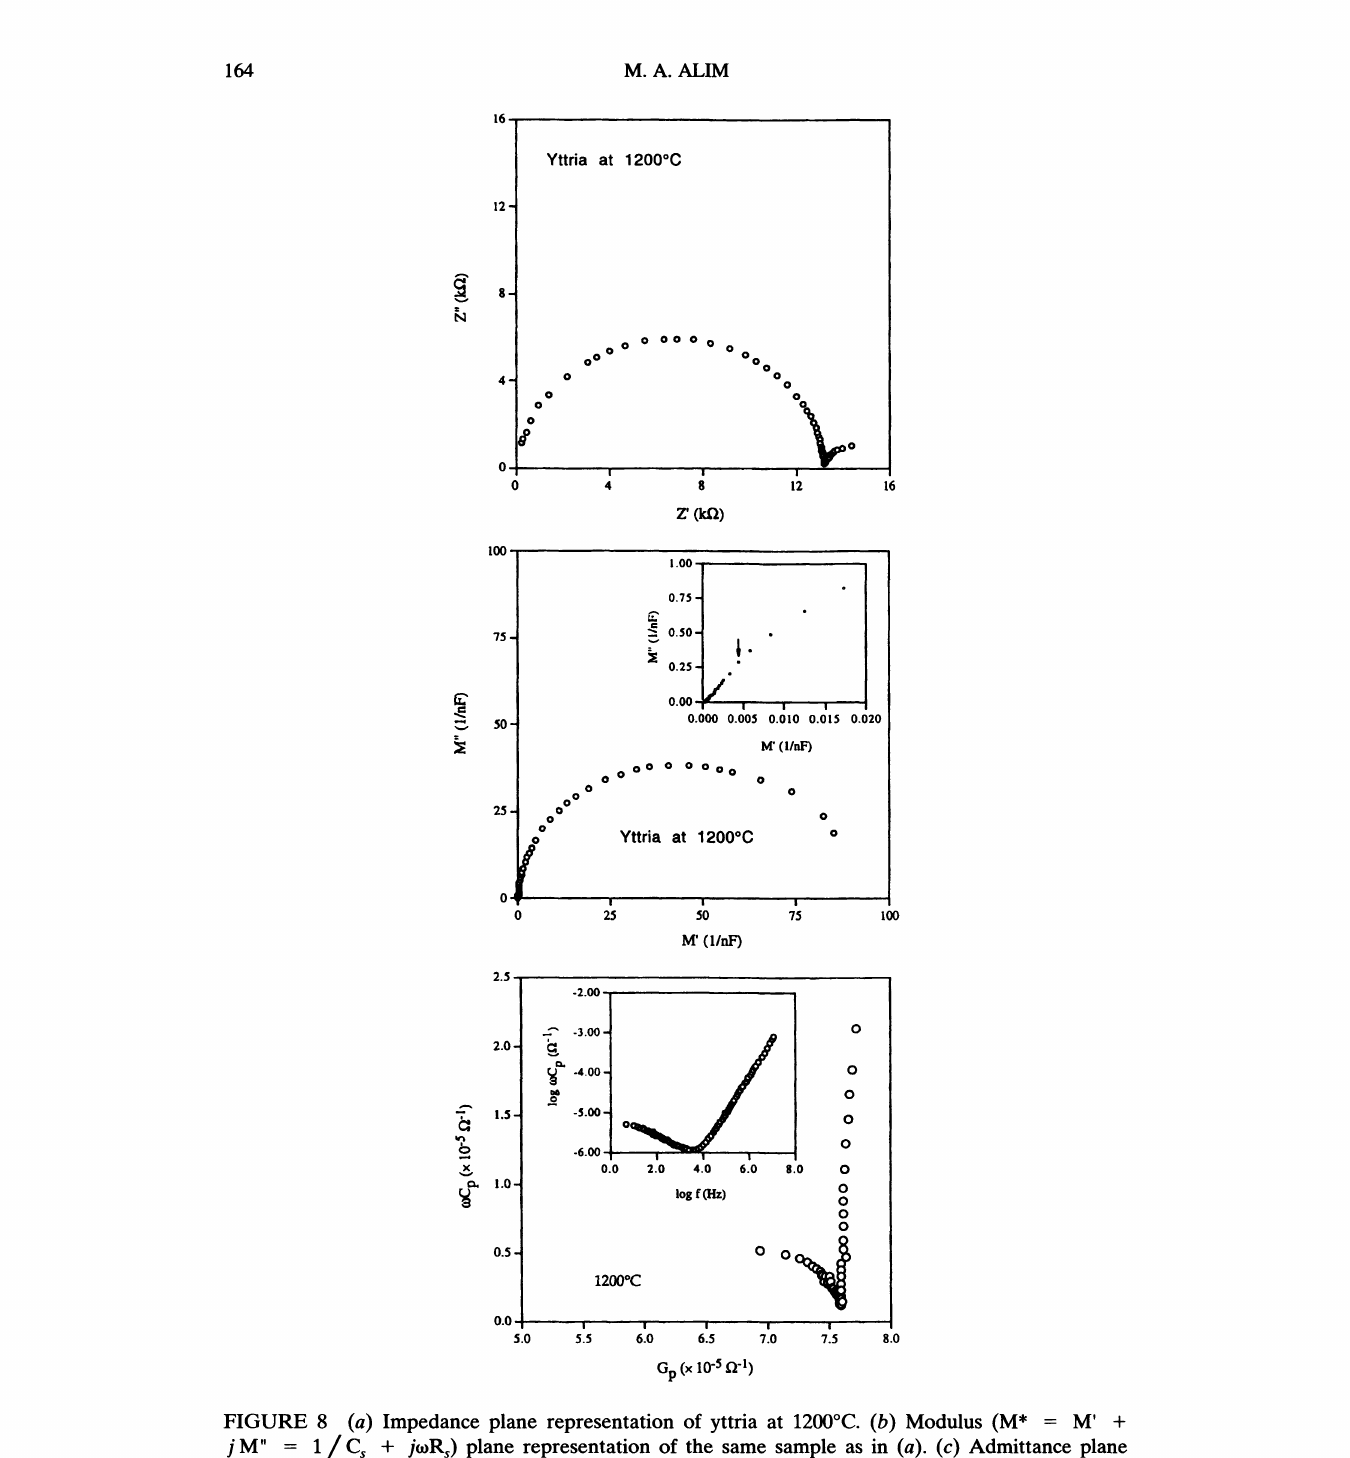
FIGURE 8 (a) Impedance plane representation of yttria at 1200C. (b) Modulus (M* M’ + j M" 1/C + jcoRs) plane representation of the same sample as in (a). (c) Admittance plane representation of the same sample as in (a) or (b). The inset is a Bode plot showing variation of oCp as a function of frequency. The linear region in the high-frequency limit yields a value C which causes vertical representation in